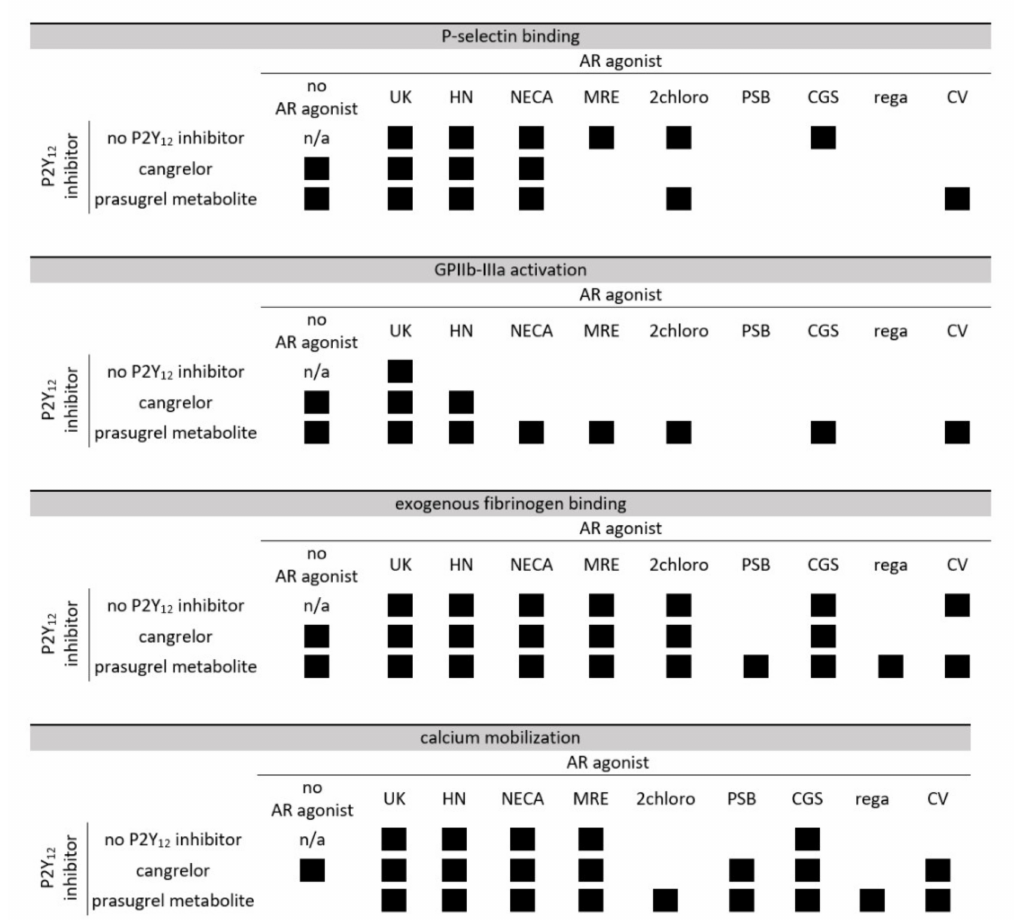
Figure 8. Comparison of AR agonist, P2Y 12 antagonist or AR agonist and P2Y 12 antagonist pairing inhibitory e ff ectiveness of ADP-induced platelet reactivity assessed by P-selectin expression, GPIIb-IIIa activation, fibrinogen binding, and calcium ion mobilization. Black boxes indicate statistically significant inhibition for P2Y 12 antagonist alone and AR agonist alone compared to control non-treated sample, as well for AR agonist and P2Y 12 antagonist pairs compared to the sample with P2Y 12